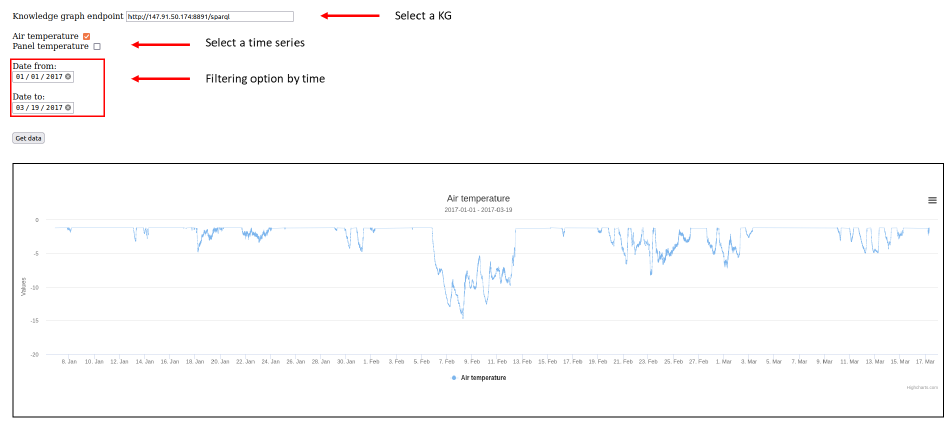
Figure 9. Energy analytics